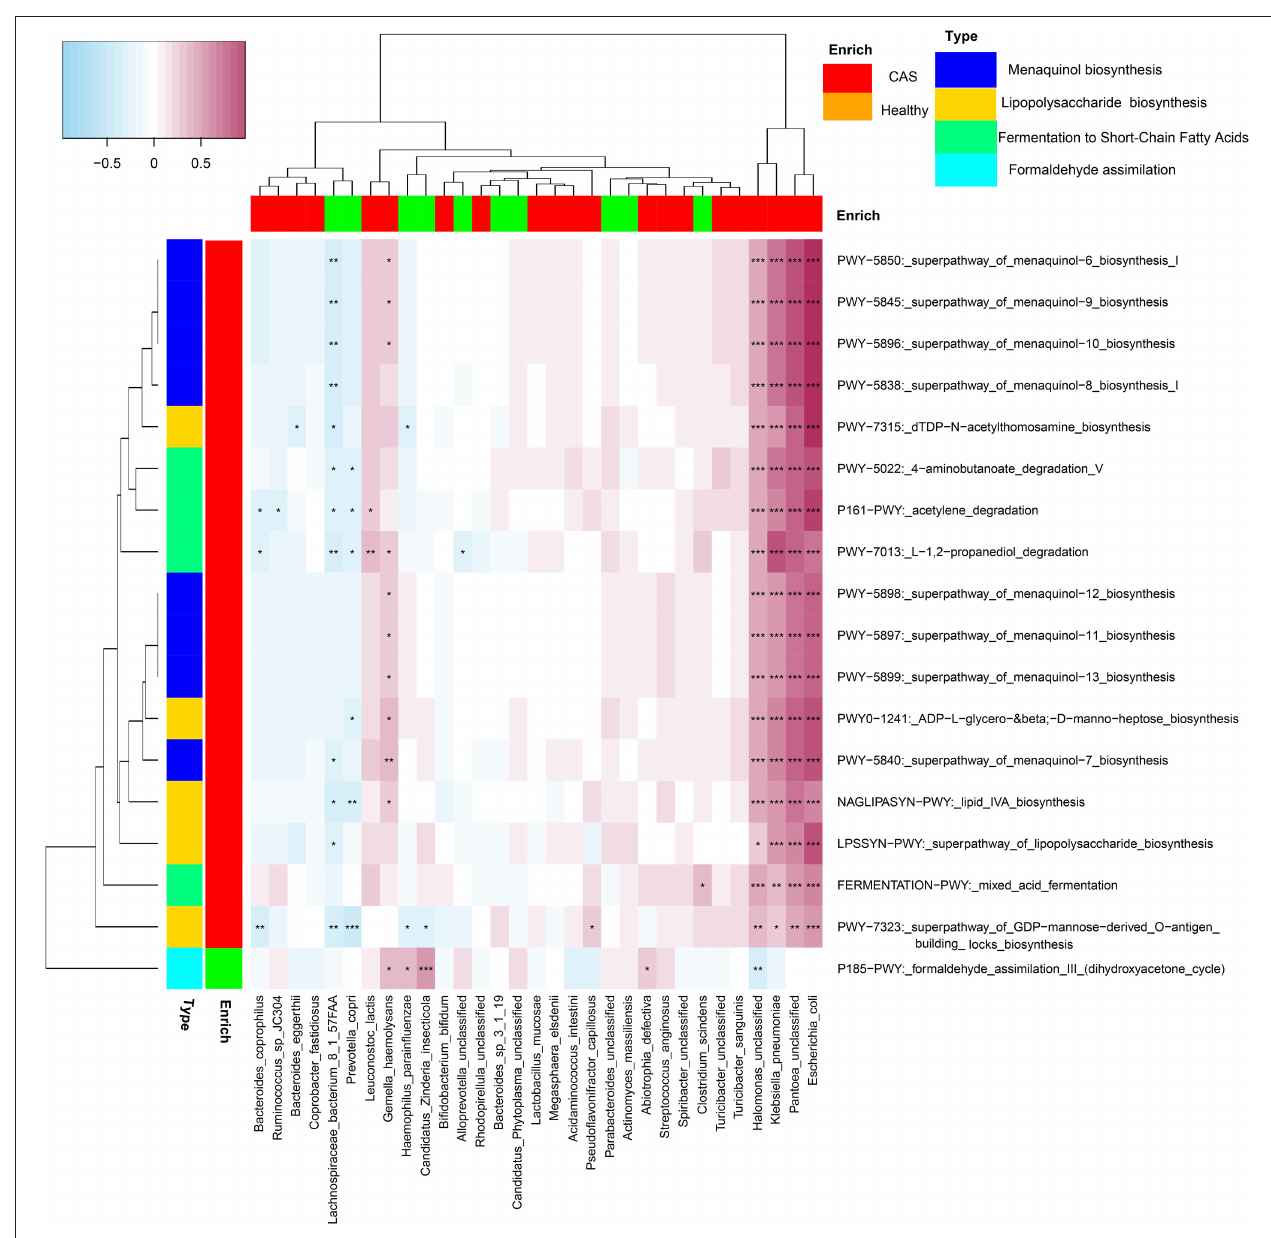
FIGURE 6 | Spearman’s correlation matrix for microbial pathways and species. The cell color indicates the correlation type (pink: positive, blue: negative). *, **, and ***denote p < 0.05, p < 0.01, and p < 0.001,